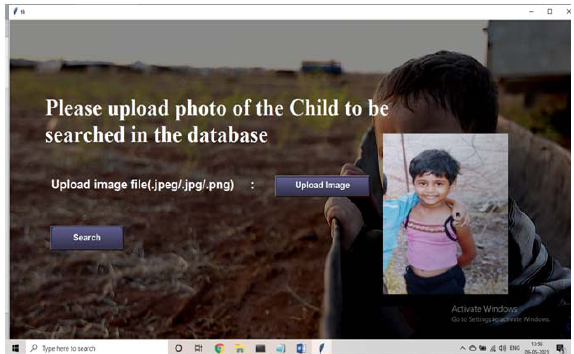
Figure 9. Page to search for a lost child using his / her photograph.